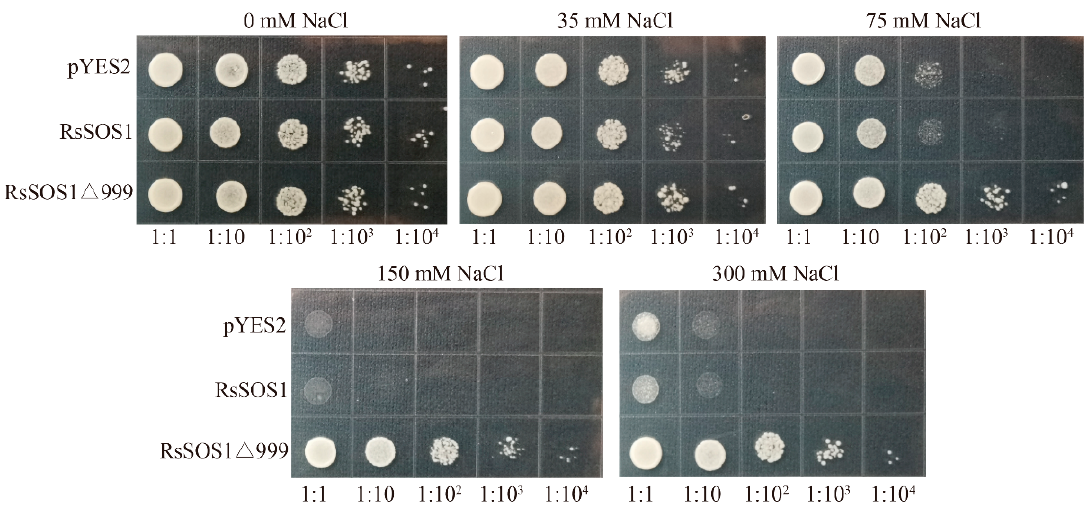
Figure 6. Function complements of RsSOS1 in AXT3 yeast. pYES2, AXT3 yeast transformed with blank vector pYES2 . RsSOS1, Transgenic yeast with full length of RsSOS1 gene. RsSOS1 △ 999, Transgenic yeast with first 2997 bp of RsSOS1 gene. Each kind of yeast transformant was diluted in multiples of 1, 10, 10 2 , 10 3 , 10 4 .